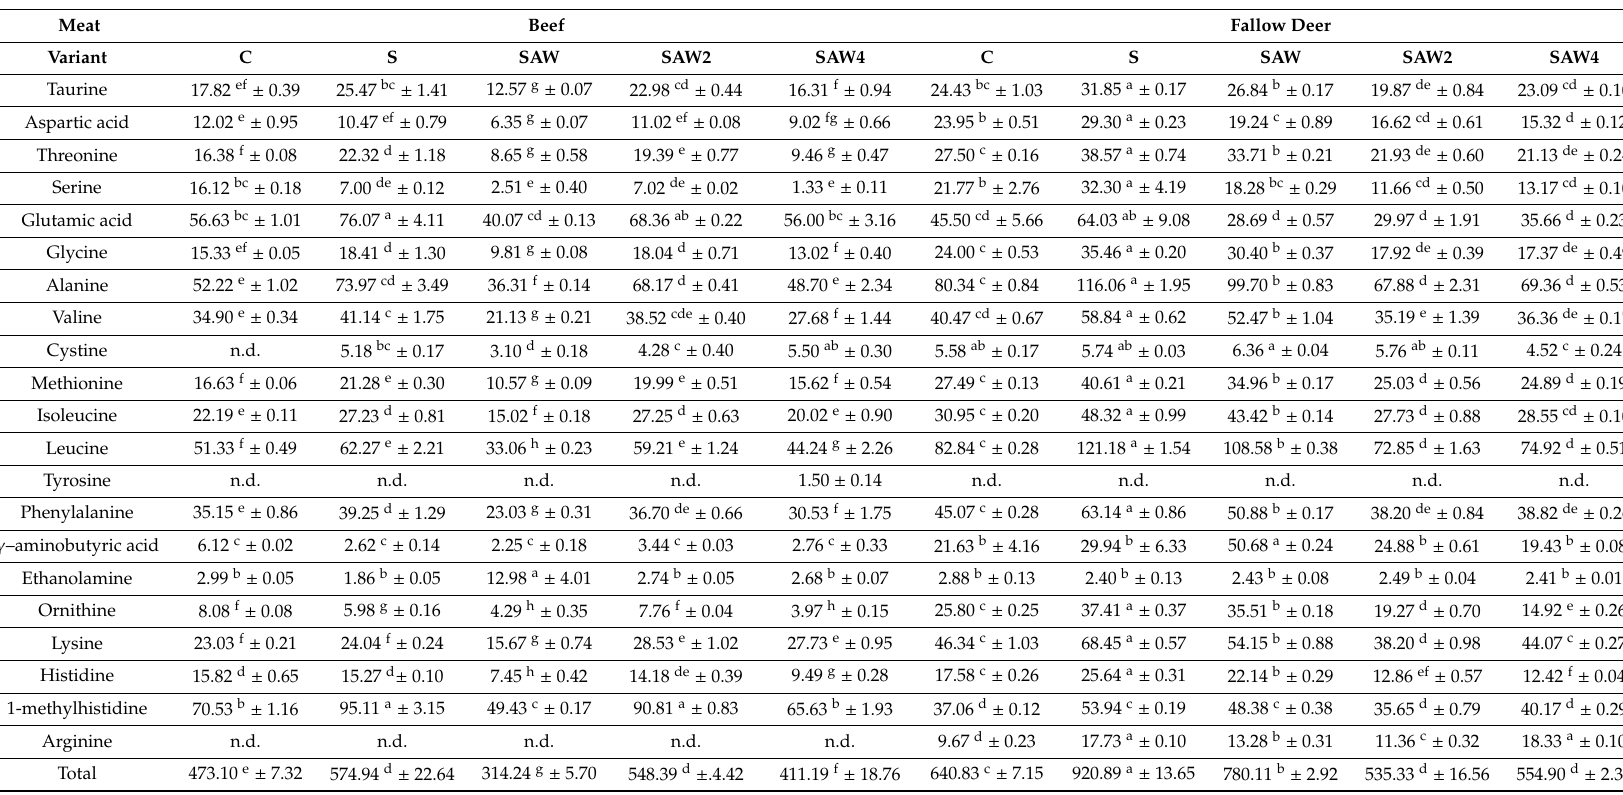
Table 6. Content of free amino acids (mg 100 g − 1 of product) in fermented sausages from beef and fallow deer meat with di ff erent addition of acid whey (mean ± standard